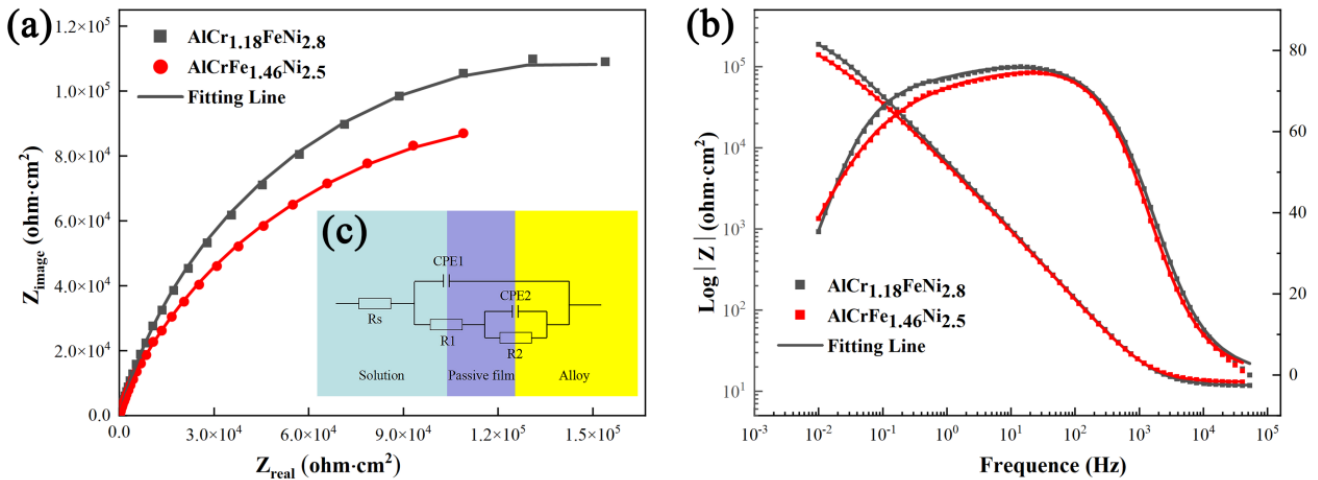
Figure 8. EIS results of AlCr 1.18 FeNi 2.8 and AlCrFe 1.46 Ni 2.5 alloys in 3.5 wt.% NaCl solution. ( a ) Nyquist plots; ( b ) Bode plots; ( c ) Equivalent electrical circuit representative of the electrode interface for the HEAs in the 3.5 wt.% NaCl solution. Table 5. Equivalent circuit parameters for impedance spectra of AlCr 1.18 FeNi 2.8 and AlCrFe 1.46 Ni 2.5 alloys in 3.5 wt.% NaCl